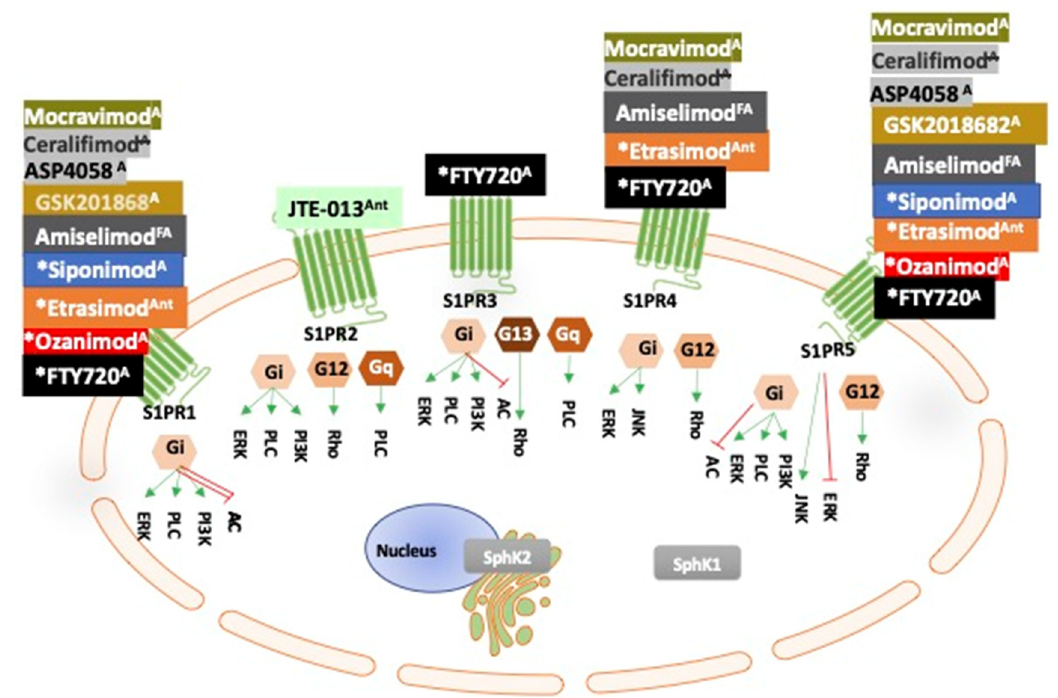
Figure 2. Sphingosine-1-phosphate receptor (S1PR) modulators in clinical trials for gastrointestinal cancers (GI) (adapted from [47]). Extracellular S1P binds to S1P transmembrane receptors (S1PR1-5) coupled to different G-proteins, which activate different internal signalling pathways within the cell. S1PR modulators bind to one or more of the S1PRs to block or activate the S1PR signalling as illustrated. Each of the S1PR modulators, as illustrated, are currently registered with National Institute of Health (NIH) clinical trials to determine their efficacy in GI inflammatory disease. * Denotes S1PR modulators approved for clinical use (see Table 3). JTE013 is a competitive antagonist specific for S1PR2 (only in pre-clinical use). A denotes agonist; Ant denotes antagonist. FA denotes functional antagonist. Note: S1PRs effects are dependent on timing and concentration of the modulator.